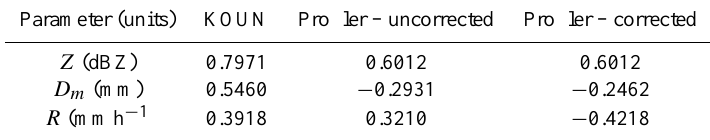
Table 6. Bias of retrieved parameters relative to 2DVD observations from 13 July squall line. Parameter (units) KOUN Profiler –